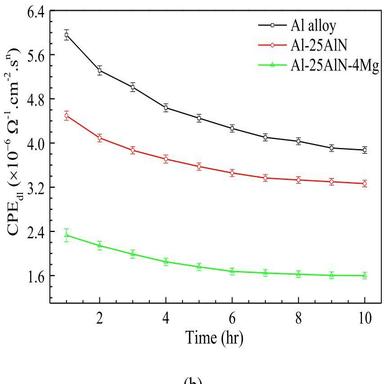
Effect of Mg and AlN composite on (a) passive layer and (b) double layer CPE magnitudes of the alloy in 0.1 M NaCl solution as a function of elapsed time.